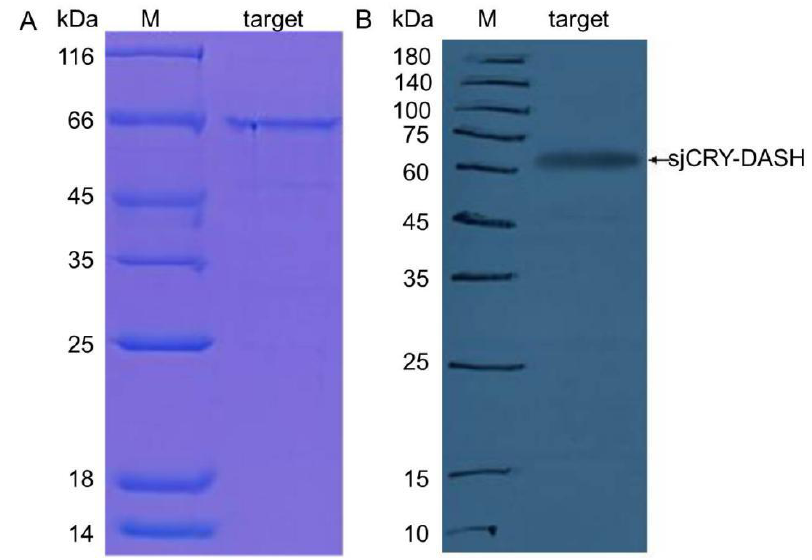
Figure 2. ( A ) Heterologous expression of sjCRY-DASH. SDS-PAGE analysis of purified sjCRY-DASH; M, protein marker; Lane target, eluted fraction with the presence of His-tagged sjCRY-DASH. ( B ) Western blot analysis of purified sjCRY-DASH. M, protein marker; target, eluted fraction with the presence of His-tagged SjCRY-DASH.